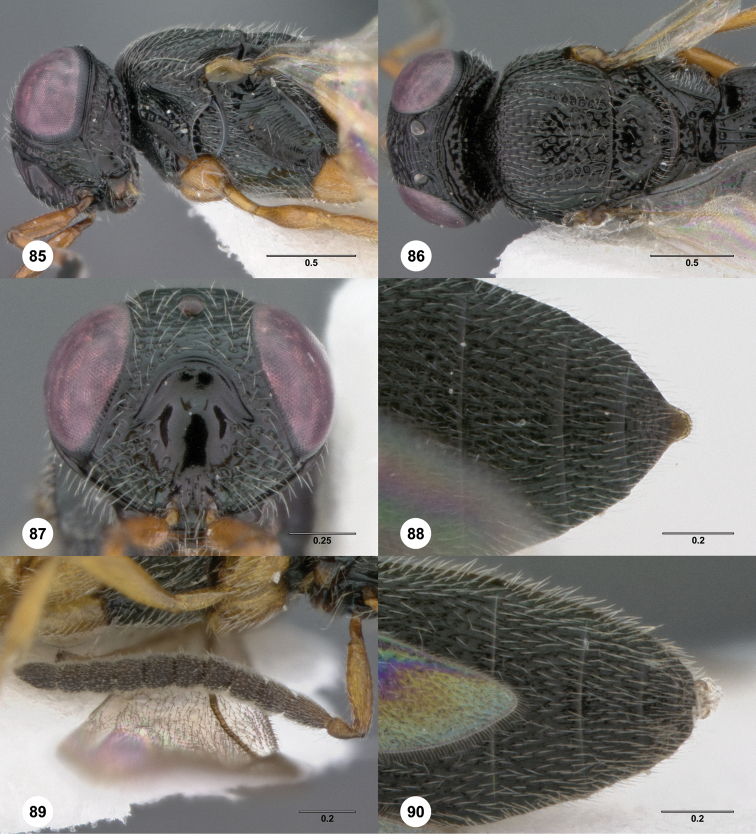
Oxyscelio dissimulationis sp. n., holotype female (QM Reg. No. T35159) 85 Head and mesosoma, lateral view 86 Head and mesosoma, dorsal view 87 Head, anterior view 88 Metasoma, dorsal view. Paratype male (OSUC 359737) 89 Antenna 90 Metasoma, dorsal view. Morphbank44